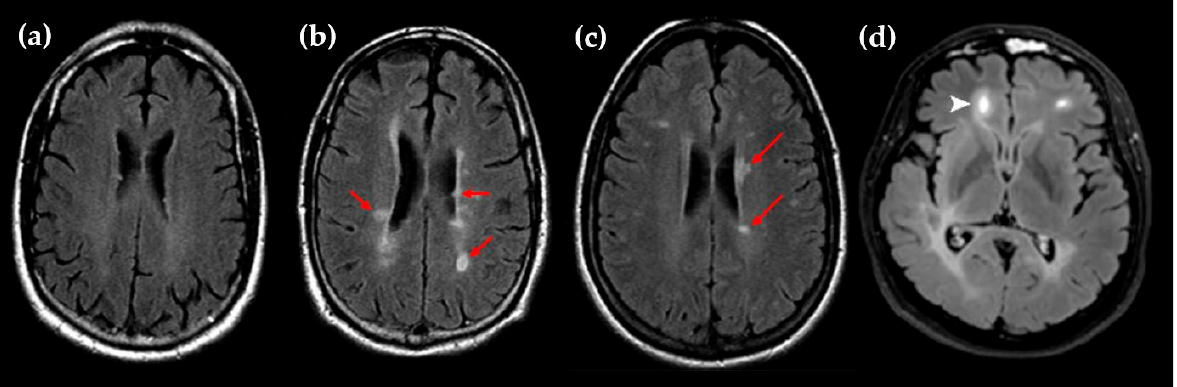
Figure 1. ( a ) Representative MRI scan (T2/FLAIR) of MS patients without brain lesions; ( b , c ) Representative MRI scans (T2/FLAIR) of MS patients with numerous brain lesions (red arrows); ( d ) Representative Gd-enhanced lesion in a frontal lobe (white arrow). The images ( a – c ) are reproduced from Dastagir et al. with the addition of red arrows (BY-NC-ND/4.0 license) [4]. Image ( d ) is reproduced from Lopaisankrit et al. without changes (CC BY/4.0 license) [5].